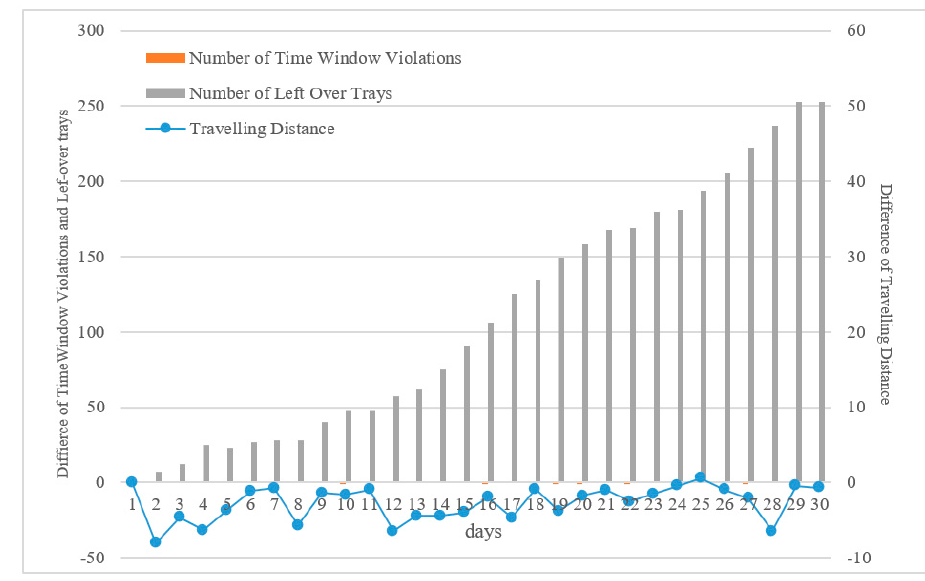
Figure 6. Di ff erence of performance between VRPSDP-TW-LO and Figure 6. Difference of performance between VRPSDP-TW-LO and VRPSDP-TW. Figure 6. Difference of performance between VRPSDP-TW-LO and VRPSDP-TW.